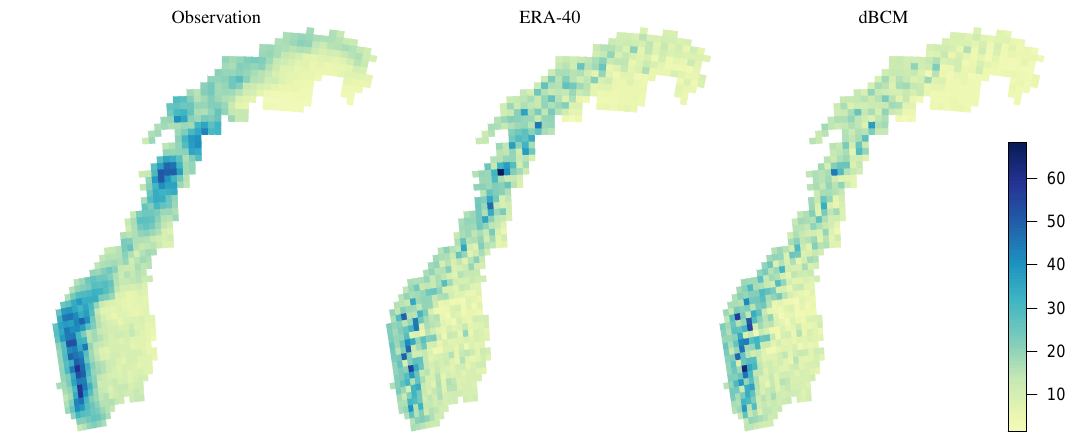
Figure 2. Pointwise 95% quantiles of OBS (left), dERA40 (middle), and dBCM (right) for the first 5-year period in the cross-validation. Table 1. Cross-validation mean square error for the 95% quantile. The best model for each fold is displayed in bold. k Model 0 Model 1 Model 2 Model 1s Model 2s Model Ref 1